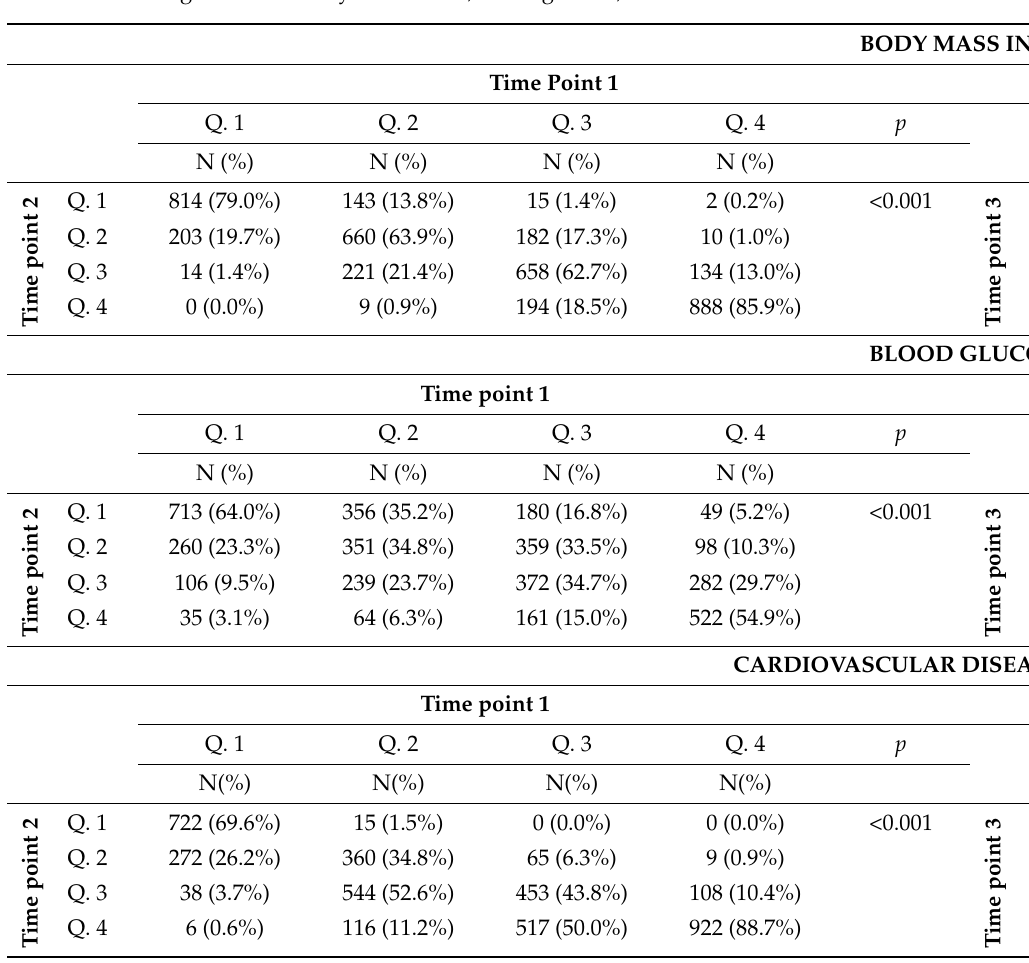
Table A1. Results of the quartile analysis. Values represent the percentage of individuals that moved from one quartile to another between time points 1 and 2 and time points 2 and 3 for the following variables: body mass index, blood glucose, and cardiovascular disease risk